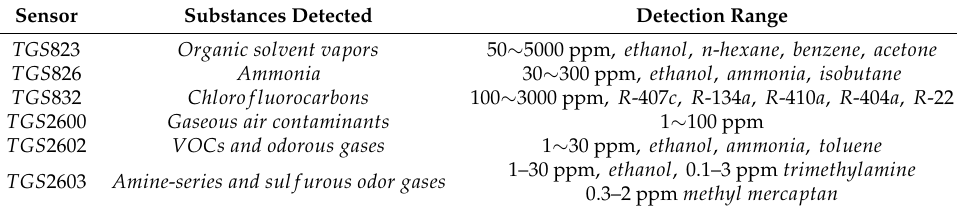
Table 1. The characteristics of semiconductor gas sensors, which were used in the multi-sensor array ([12], https://www.figaro.co.jp/en (accessed on 4 December